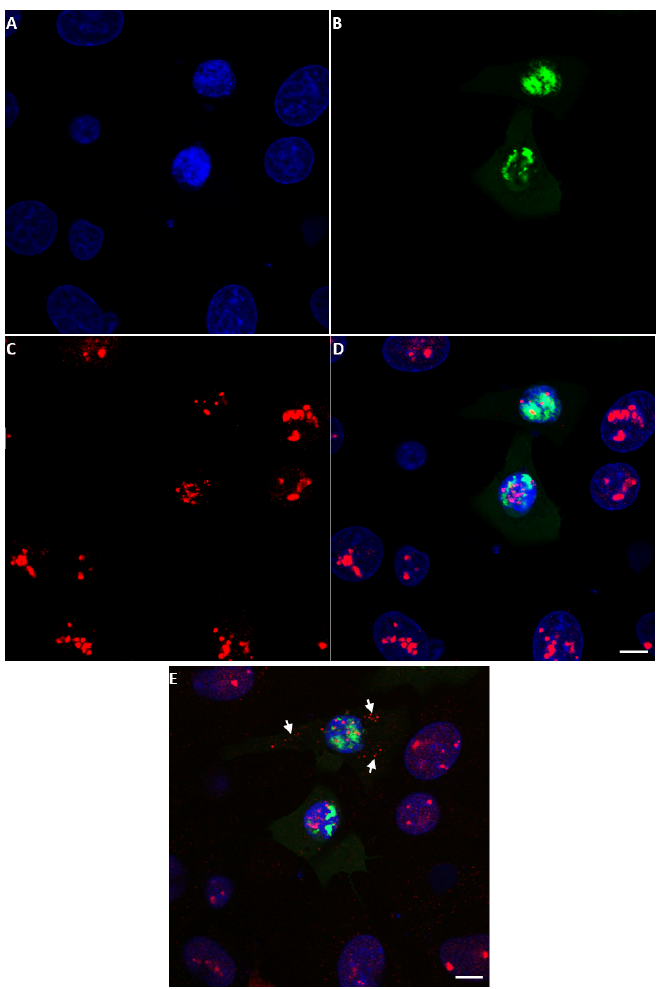
Figure 10. Confocal immunofluorescence microscopy of BSR cells transfected with pCI-BTV1NS5- GFP (expressing NS5-GFP of BTV-1) at 18 h post-transfection. ( A ): cells were stained with DAPI. ( B ): green fluorescence of the NS5-GFP fusion protein is visible in the nucleus. ( C ): fibrillarin in the nucleoli, and ( D ): the merging of ( A – C ). The green fl uorescence of the fusion protein is located in the vicinity of nucleolar material (red fl uorescence: anti- fi brillarin antibodies) and throughout the nucleus. A di ff erent focal plane ( E ) shows the top cell expressing the NS5-GFP fusion protein having punctate nucleolar ma tt er (red) both in the nucleus and the cytoplasm (indicated by white arrows). The scale bar represents 5 µm.